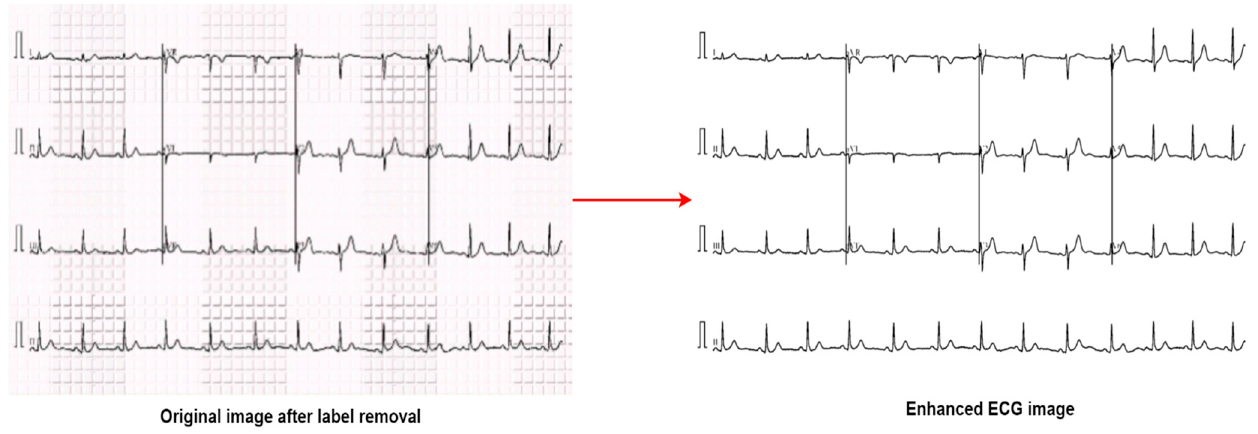
Figure 8. Original image (after label removal) and the enhanced image.